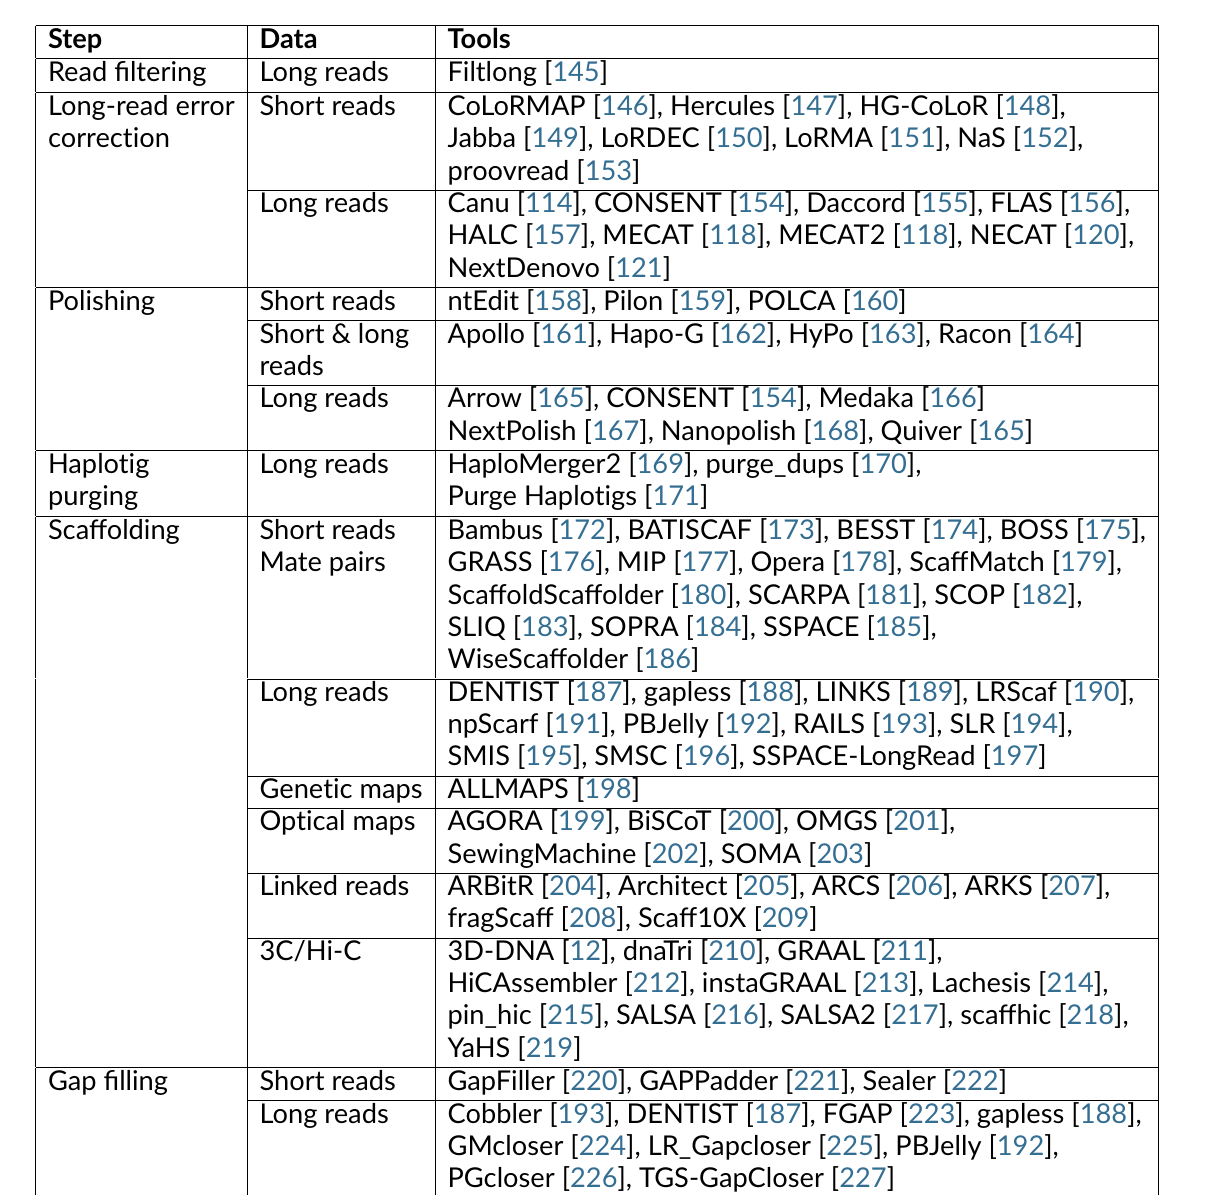
Figure 5 – Assembly pipeline, including the assembly and the pre/post-processing steps. Table 2 – Assembly pre and post-processing tools for haploid